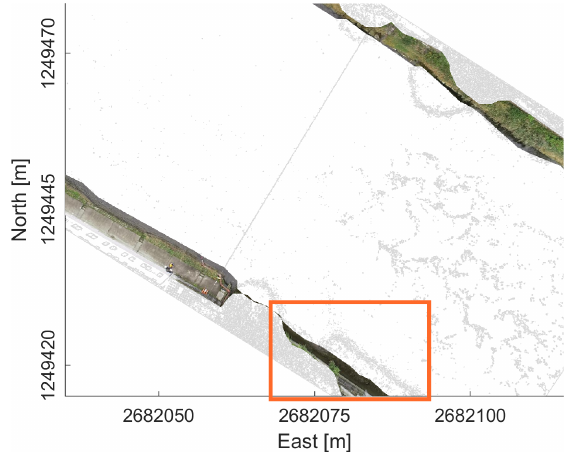
Figure 2. Binary mask applied on video A RF in